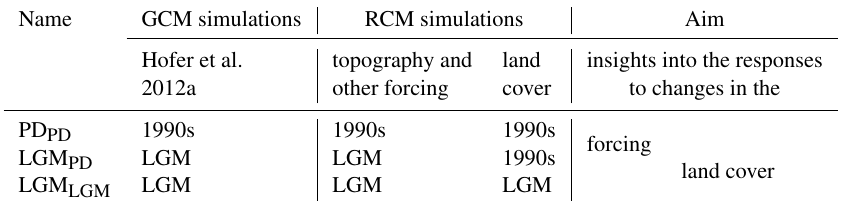
Table 1. Set of simulations used in the asynchronous coupling and sensitivity experiments. First column indicates the name of the simulation, second and third columns the forcing used in the global and regional climate models, and fourth column the purpose of the comparison.